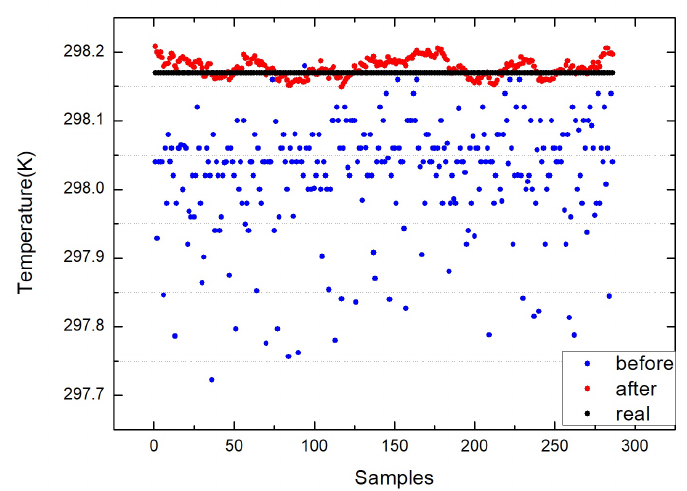
Figure 6. Output result (before) of directly aligning the blackbody, the final output result (after) after aligning the standard blackbody after algorithm correction, and the actual temperature (real) of the standard blackbody.